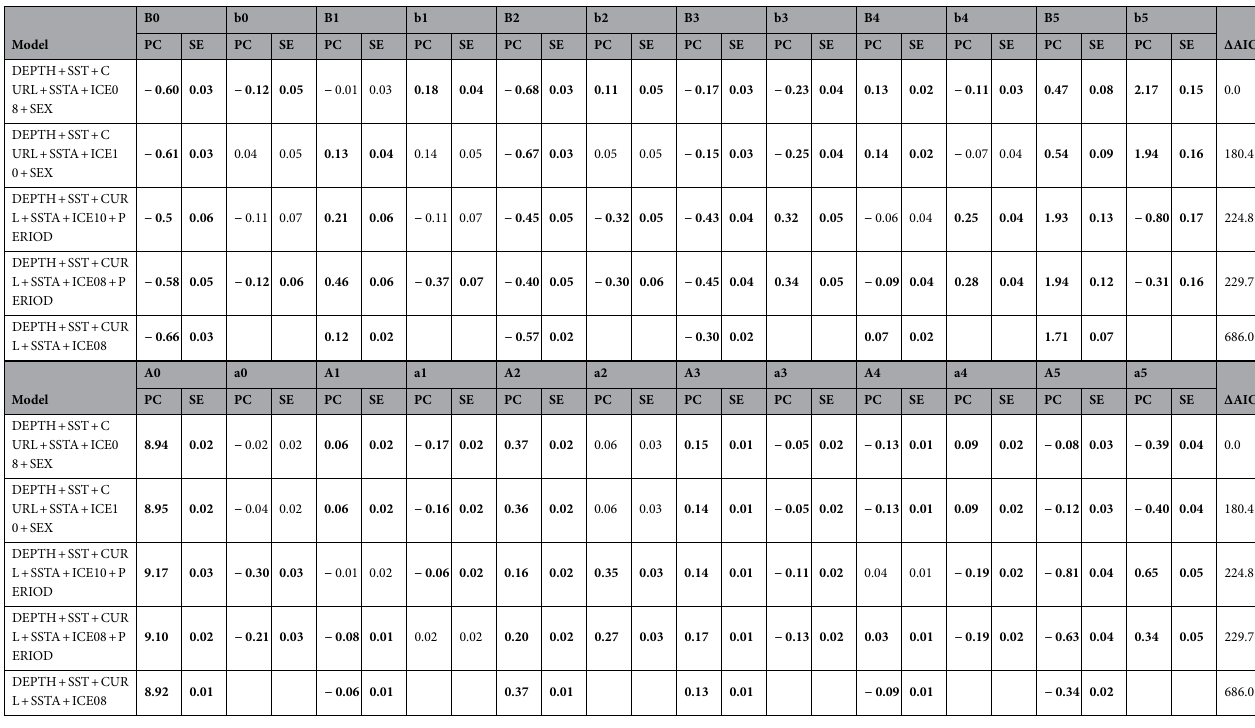
Table 3. Results for the five best P -models. Maximum likelihood estimate for parameter coefficients (PC) and the corresponding standard error (SE) are provided. Significant parameter estimates ( P ≤ 0.05) are denoted in bold. Values for ε 1 and ε 2 were fixed at